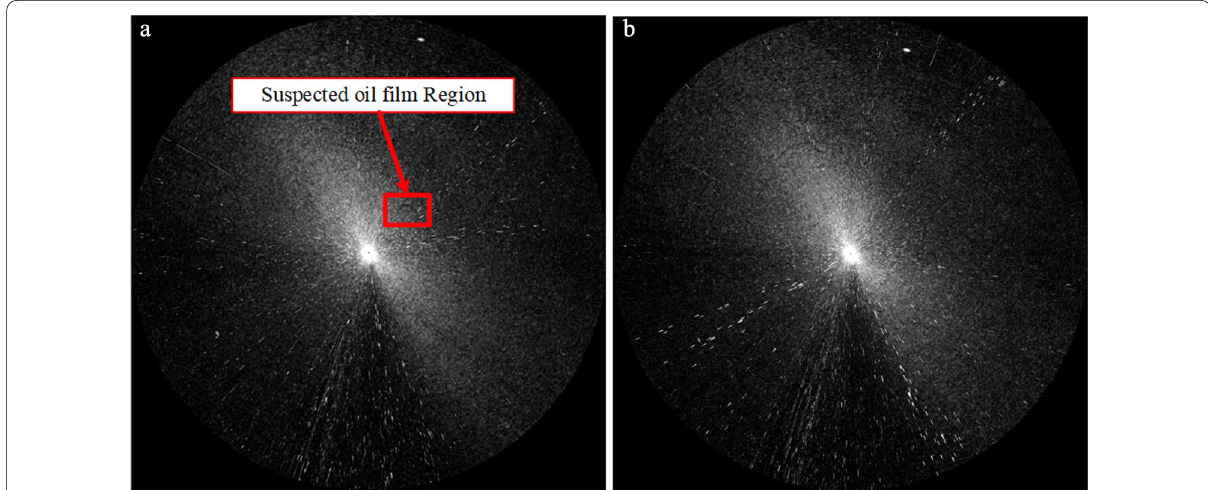
Fig. 9 Discrimination of unreal oil spills. a , b Were collected at 14:07:50 and 14:08:19 on August 12, 2015, respectively. a Suspected oil films appeared at the first time; b suspected oil films disappeared in the next image